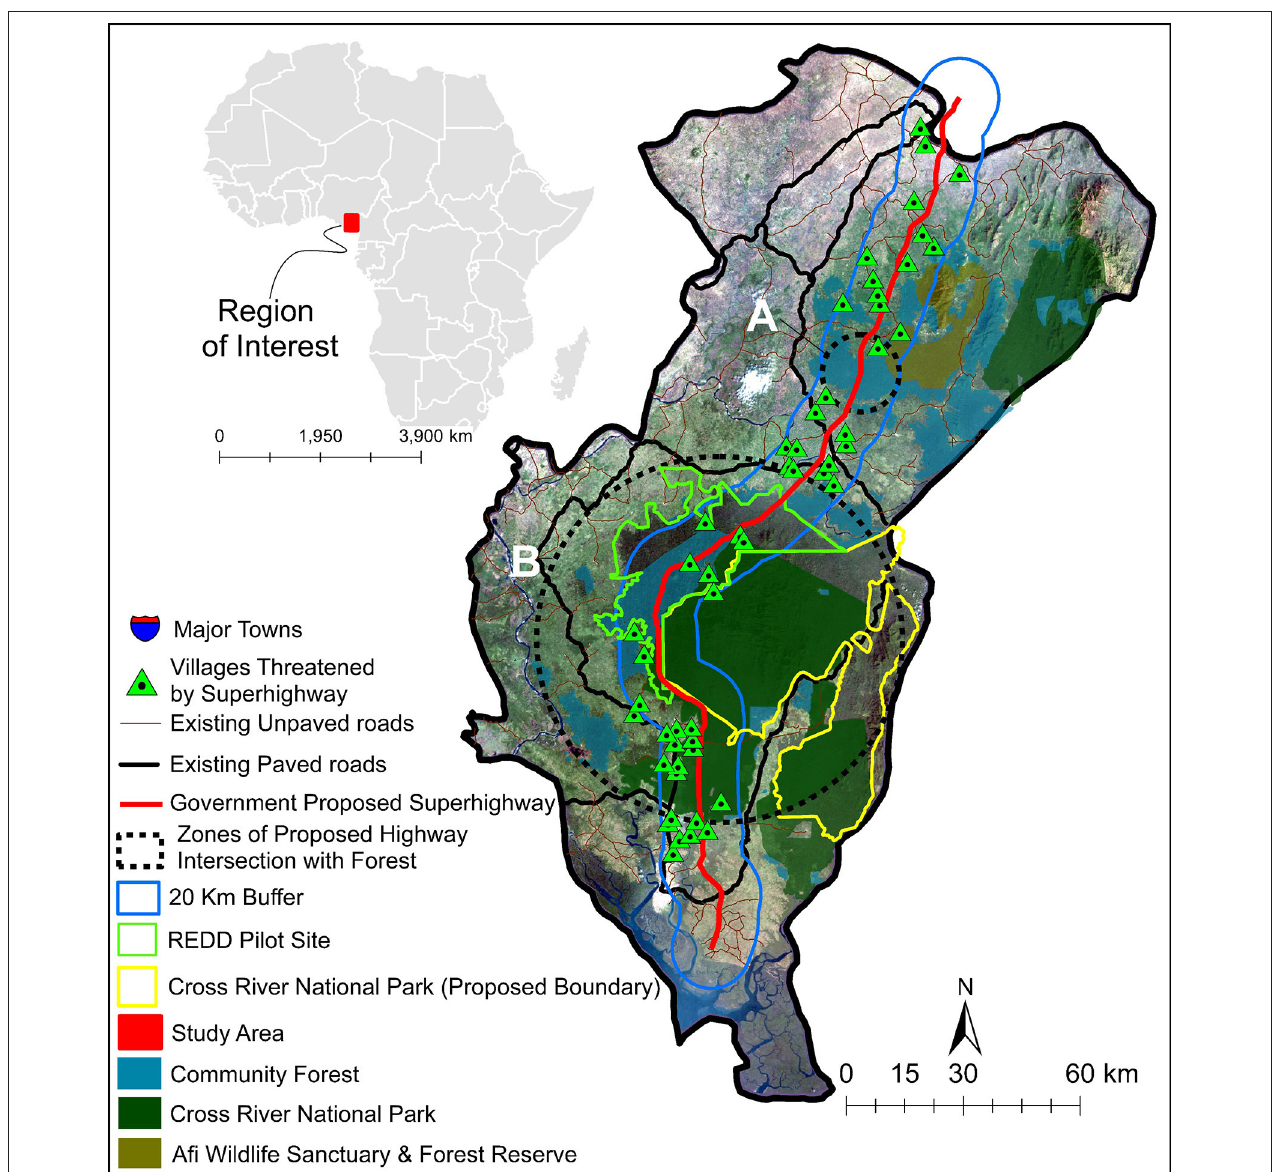
FIGURE 2 | (Top left) An inset of Africa depicting the study region. (Right) The proposed 260 km-long Cross River Superhighway route with its originally proposed 20 km-wide buffer zone in Cross River State, Nigeria. Circles A and B depict areas of intersection between the proposed superhighway, the Cross River national park and community